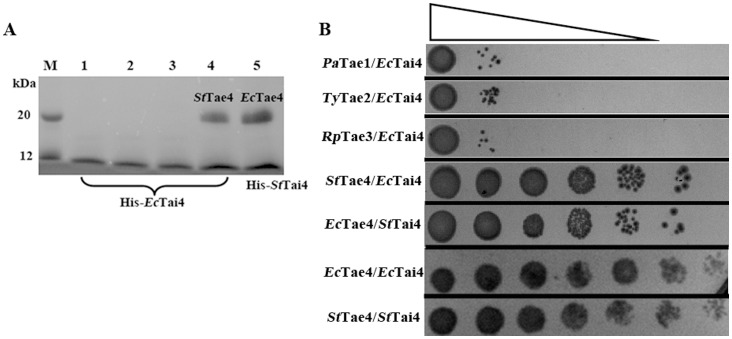
The in vitro and in vivo interactions studies.(A) Pull-down assays between His-EcTai4 and noncognate and cognate effectors. M, marker; 1, EcTai4-PaTae1; 2, EcTai4-TyTae2; 3, EcTai4-RpTae3; 4, EcTai4-StTae4; 5, StTai4-EcTae4. (B) Growth of E. coli co-expressing EcTai4 and various effectors above in the periplasm representing the cross-immunity between them. The cells were prepared with serial 10-fold dilutions from left to right.